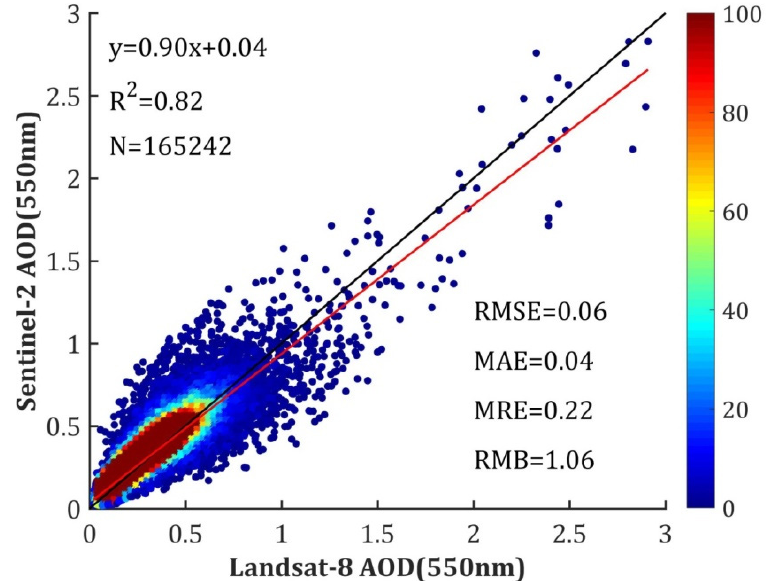
Figure 8. Comparison of the AOD retrievals for Landsat-8 and Sentinel-2B on 4 December 2018.